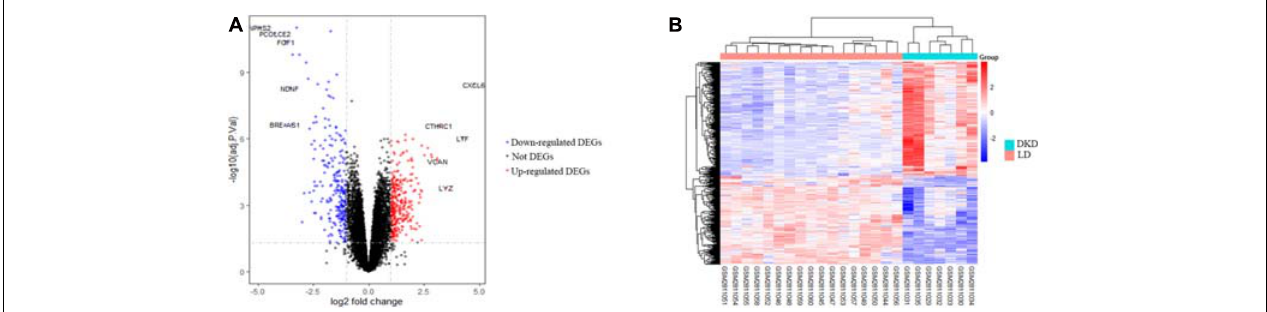
FIGURE 1 | DEGs between seven patients with DKD and seventeen LDs from GSE104954. (A) Volcano plot of all genes in GSE104954 and top 10 DEGs were annotated. (B) Heatmap of DEGs identified.